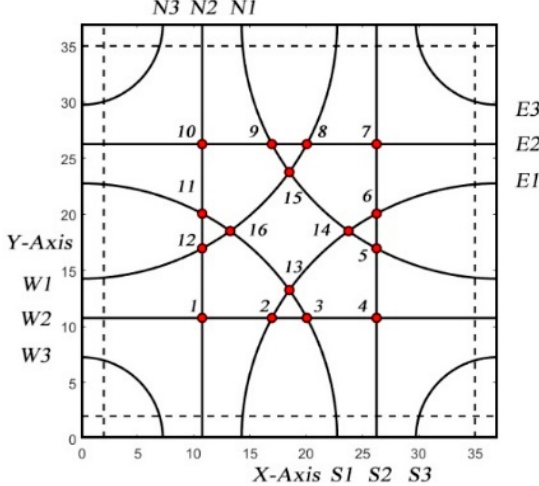
Figure 2. All possible trajectories and overlapping points. Table 1. Conflict relationships among different lanes.